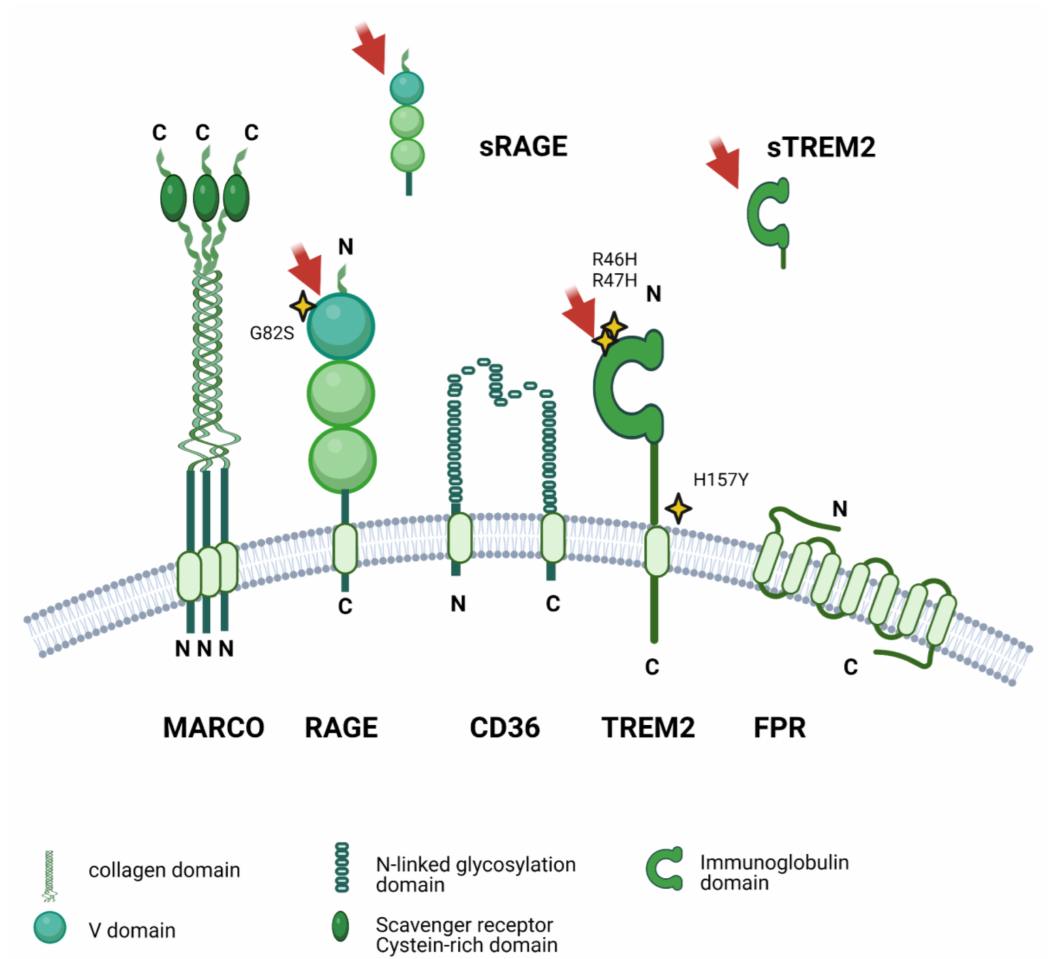
Figure 1. Membrane topology and domain architecture of microglial A β -binding receptors . Some receptors are shown exemplarily to underpin the diverging domain architecture und potential A β - binding site positions as far as identified (red arrows). Relative location of polymorphisms to binding sites are indicated by yellow diamonds. Proportion of domains has been neglected. For RAGE, binding of A β is assumed to occur as a dimer on the dimeric receptor [16]. In addition to cleaved soluble RAGE and TREM2, additional soluble splice forms exist